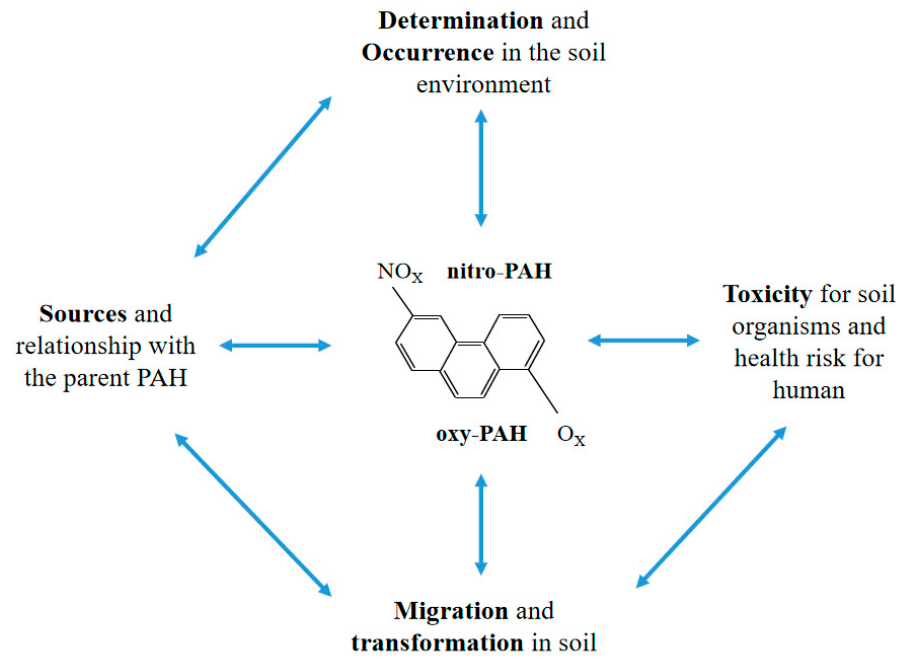
Figure 1. Structure diagram of this review.